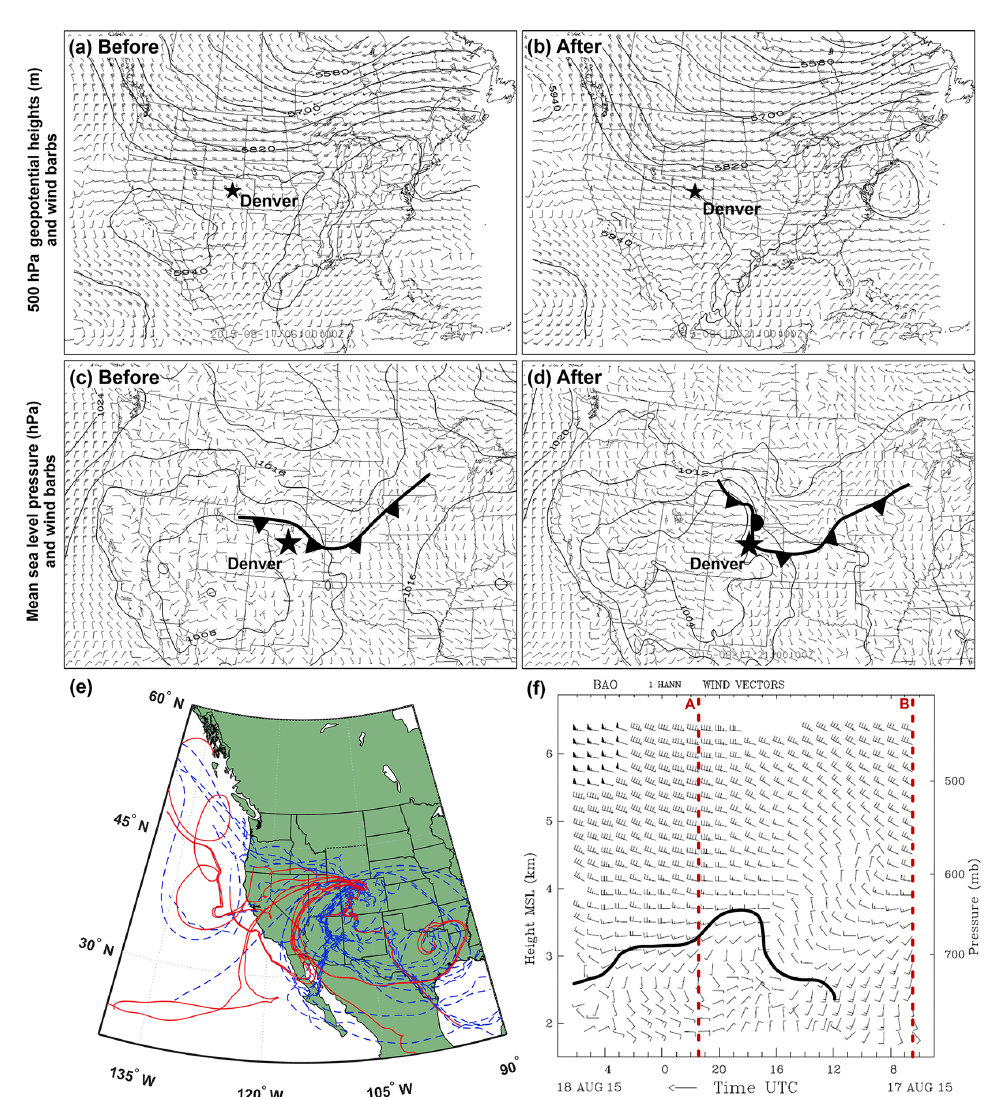
Figure 7. Meteorological analysis for event 1 (17 August 2015). Top row shows 13km resolution RAP gridded dataset of 500hPa geopo- tential heights (black contours) with 500hPa wind velocities (flags: 25ms − 1 ; barbs: 5ms − 1 ; half barbs: 2.5ms − 1 ) from before (a) and after (b) the passage of a cold front at 06:00 and 21:00UTC, respectively. Middle row shows mean sea-level pressure (black contours) with near-surface wind velocities (flags and barbs as above) from before (c) and after (d) the cold-frontal passage. Standard frontal notation is used. (e) Ten-day air mass backward trajectories initiated every 6h at 500, 1000, and 2000ma.m.s.l. during the time period surrounding event 1 (15–18 August). Trajectories in red correspond to the haziest day (17 August), and the blue dashed trajectories show the remaining. (f) Time–height section of hourly-averaged wind profiles from the 449MHz wind profiler at BAO between 06:00UTC on 17 August and 06:00UTC on 18 August (flags and barbs are as above). The bold black line denotes the approximate frontal shear boundary. The pair of red dashed lines shows the RAP analysis times before (“B”) and after (“A”) the cold-frontal passage at BAO. Time increases from right to left to portray the advection of upper-level synoptic features from west to